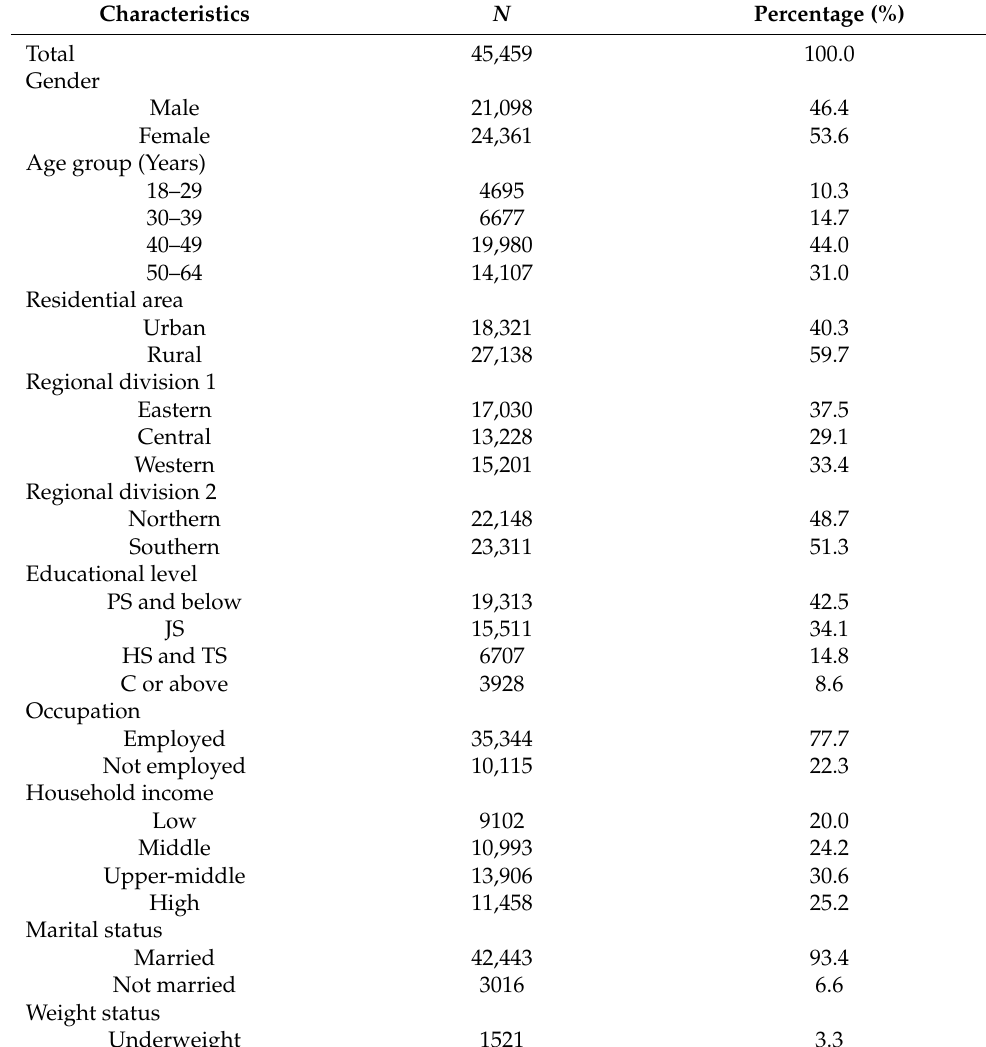
Table 1. Descriptive characteristics of the study